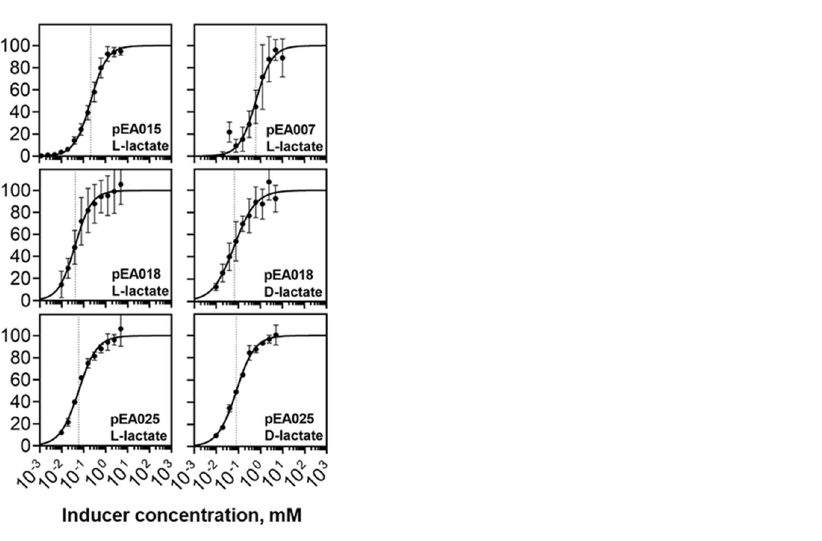
Figure 3. Dose–response curves of L- and D-lactate inducible systems. Relative normalized fluorescence of E. coli DH5 α , C. necator H16 and P. putida KT2440 harbouring pEA015 with Ec LldR / P lldP , pEA007 with Cn GntR / P H16_RS19190 , and pEA018 with Pa PdhR/P lldP , and pEA025 with Pf PdhR/P lldP determined in response to different concentrations of either L- and D-lactate 6 h after inducer addition. Level range of L- or D-lactate varied from 0 to 5 mM (0, 0.0003, 0.0006, 0.0012, 0.0024, 0.0048, 0.009, 0.019, 0.039, 0.078, 0.156, 0.313, 0.625, 1.25, 2.5, and 5 mM). The dose–response curves were fitted using Hill function as described in Methods. The maximum level of reporter output b max was set to 100%. K m is marked using a dotted line. Cells were grown in minimal medium containing 0.4% glucose (in the case of C. necator H16 supplemented with 0.4% gluconate). Error bars represent standard deviations of three biological replicates. Source data are provided in Supplementary Data